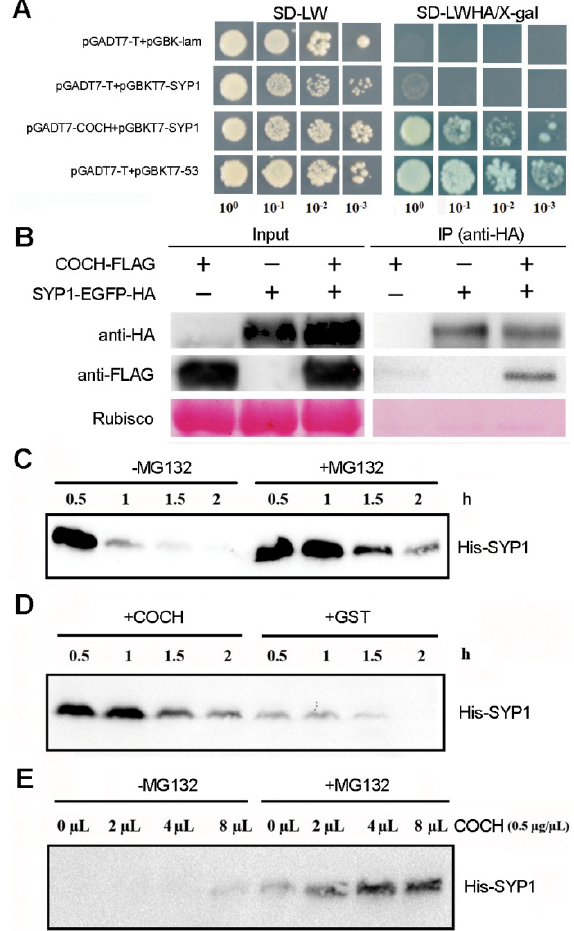
Figure 6. COCH interacted with SYP1. ( A ) Yeast two-hybrid assays for COCH and SYP1. The bait protein was expressed as a binding domain fusion and the indicated prey proteins were expressed as activating domain fusions in yeast AH109 cells. Transformed yeast was grown on selective media lacking Leu and Trp (-2) or lacking Ade, His, Leu, and Trp (-4) plus X-α-Gal to test protein interaction. 10 0 , 10 −1 , 10 −2 and 10 −3 represent dilution series. ( B ) COCH was co-immunoprecipitated with SYP1. ( C ) Degradation assay of His-SYP1 performed in a pea cell-free system with or without MG132. ( D ) Degradation assay of His-SYP1 performed in a pea cell-free system with COCH or GST. ( E ) Degradation assay of His-SYP1 performed in a pea cell-free system with or without MG132 and different amounts of COCH.